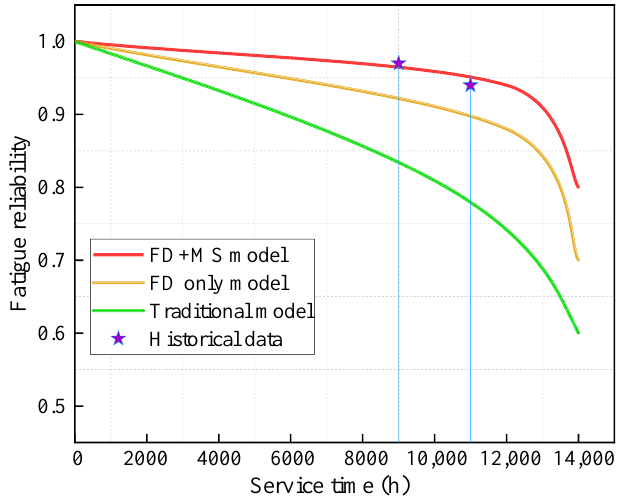
Figure 17. Prediction result of reliability model.